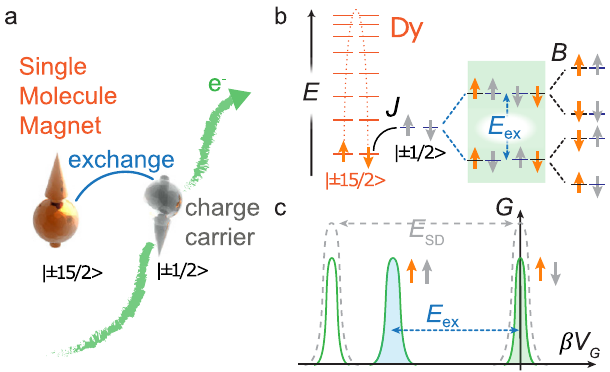
Fig. 1 Exchange-induced polarization in molecular